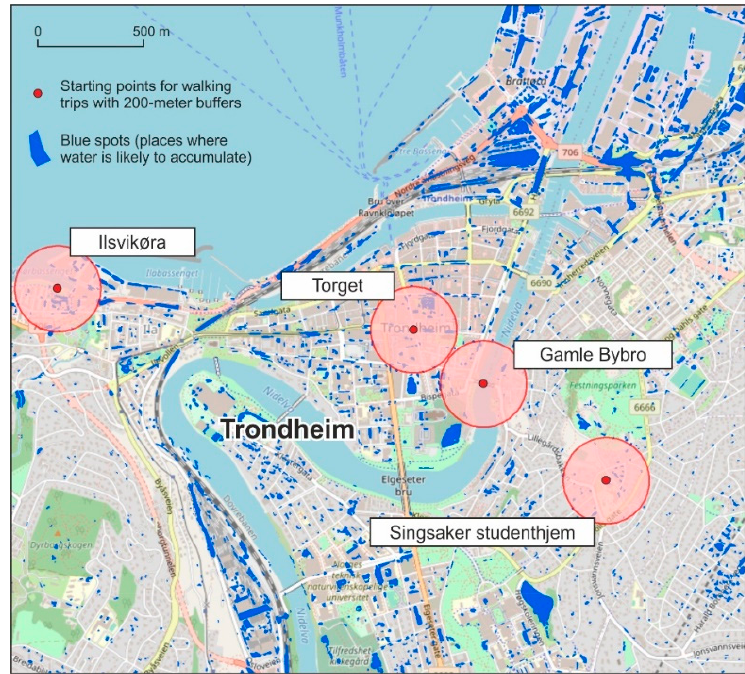
Figure 1. “Blue spots” in the city of Trondheim and four places used as starting points for the walks in the empirical study. The places are shown along with their 200-m